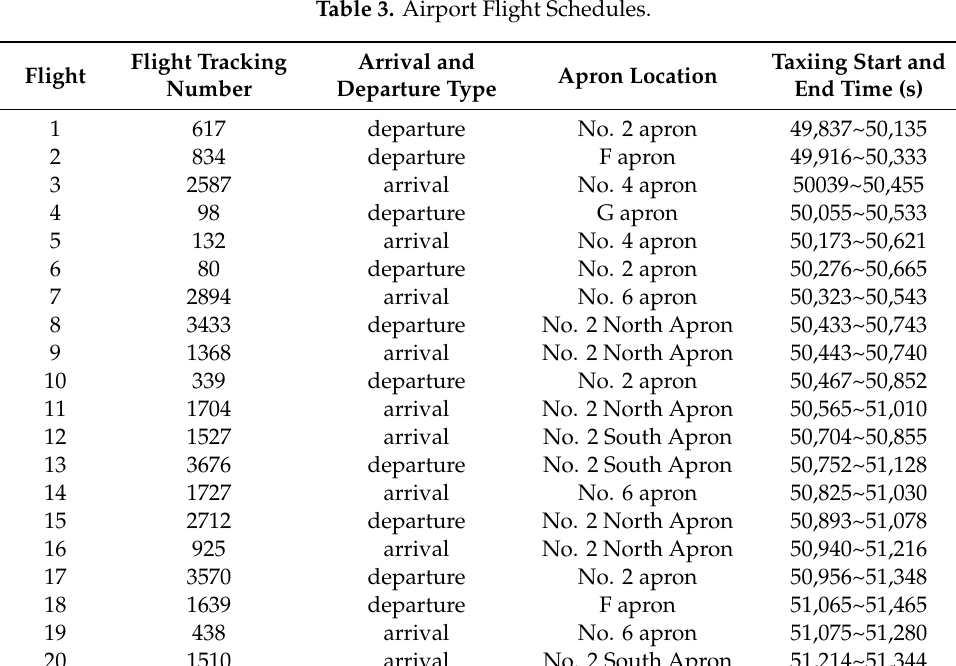
Figure 6. Network diagram of taxiway at Hongqiao Airport. Table 3. Airport Flight